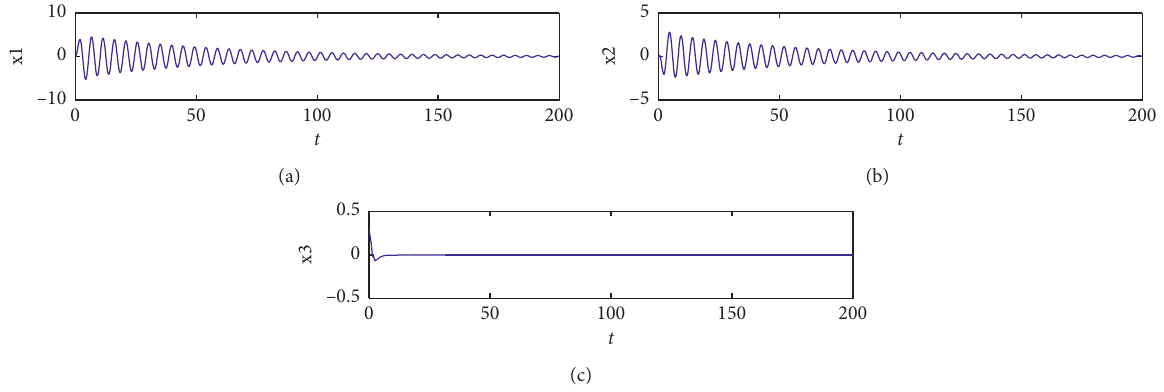
Figure 2: System (31) is asymptotically stable with α � 1.22.